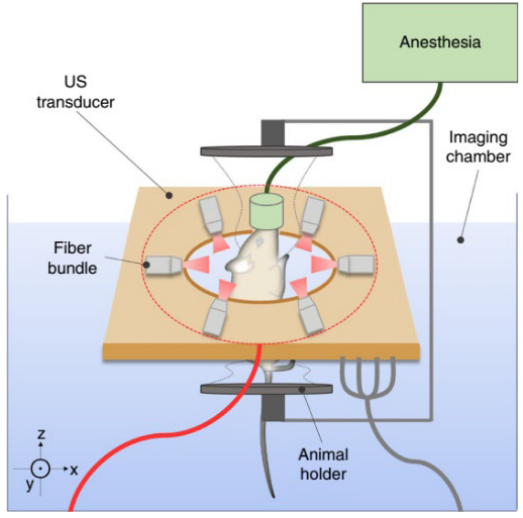
Fig. 11. Diagram of the USCT enhanced PACT imaging system. Reproduced with permission from Ref.